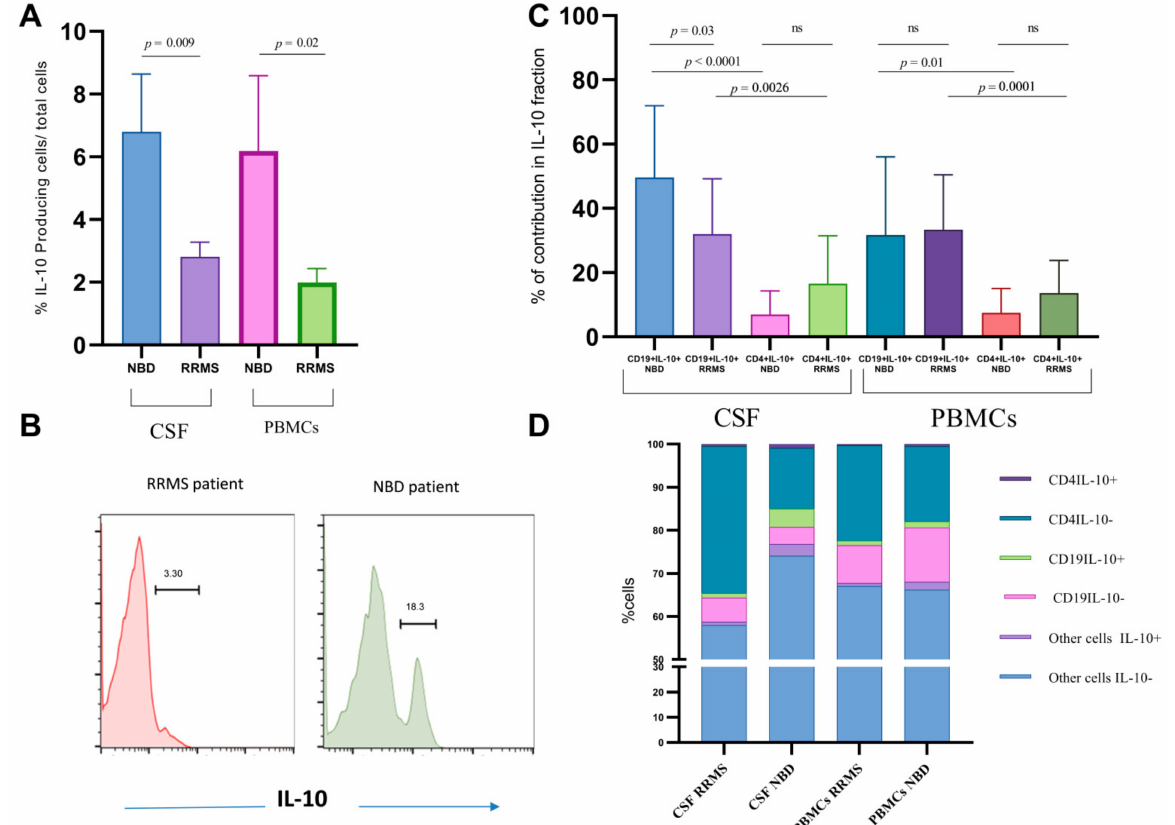
Figure 1. Flow cytometry analysis of IL-10-producing cells in CSF and total PBMCs. ( A ) Comparative histogram of IL-10 frequencies within the CSF and total PBMCs from RRMS ( n = 22) and NBD ( n = 11) patients. ( B ) A Representative intracellular expression of IL-10 in the total CSF of RRMS and NBD patients. ( C ) Histogram representation of comparative contribution of CD19 and CD4 cell subsets in CSF and PBMCs of NBD and RRMS patients. The results are mean ± SEM with. Boxplots represent the percentage of IL-10-producing CD19 and CD4 cells in the CSF and PBMCs of neuro-immunological disorders RRMS ( n = 22) and NBD ( n = 11). Statistical significance between two groups was assessed using the Wilcoxon–Mann–Whitney test. ( D ) Bar charts plots of the percentages and frequencies of IL-10 positive cells in the whole CSF and blood. Representation ofCD4 IL-10+ cells, CD4 IL-10- cells, CD19 IL-10+ cells, CD19 IL-10- cells and the otherundetermined cells secreting or not IL-10 of NBD and RRMS patients. ns = non